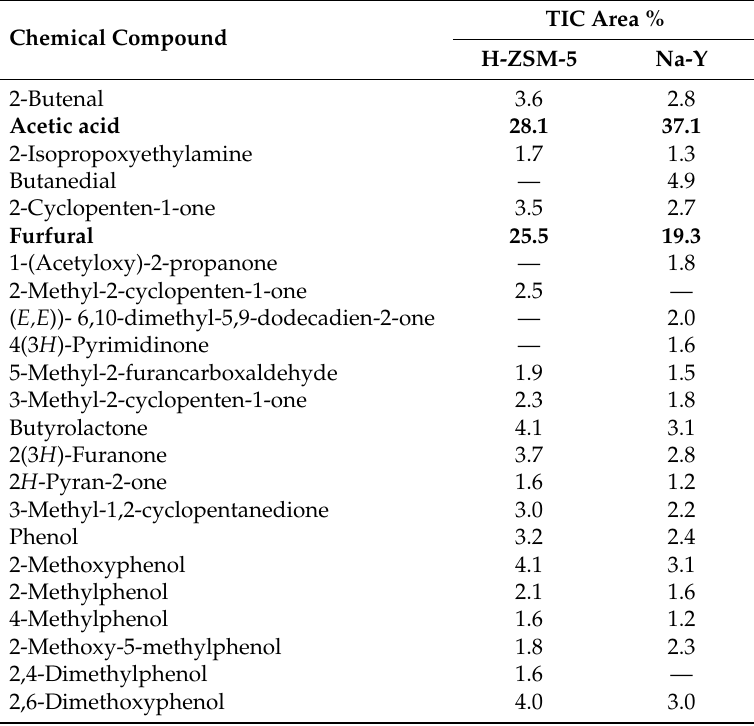
Table 7. Component concentration of the water-rich fraction from the second